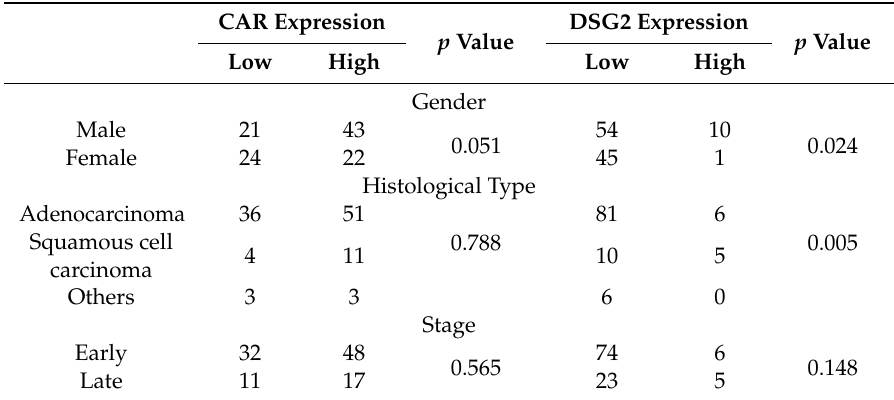
Table 2. Relationships among di ff erentiation and clinicopathological variables in advanced lung adenocarcinoma patients.